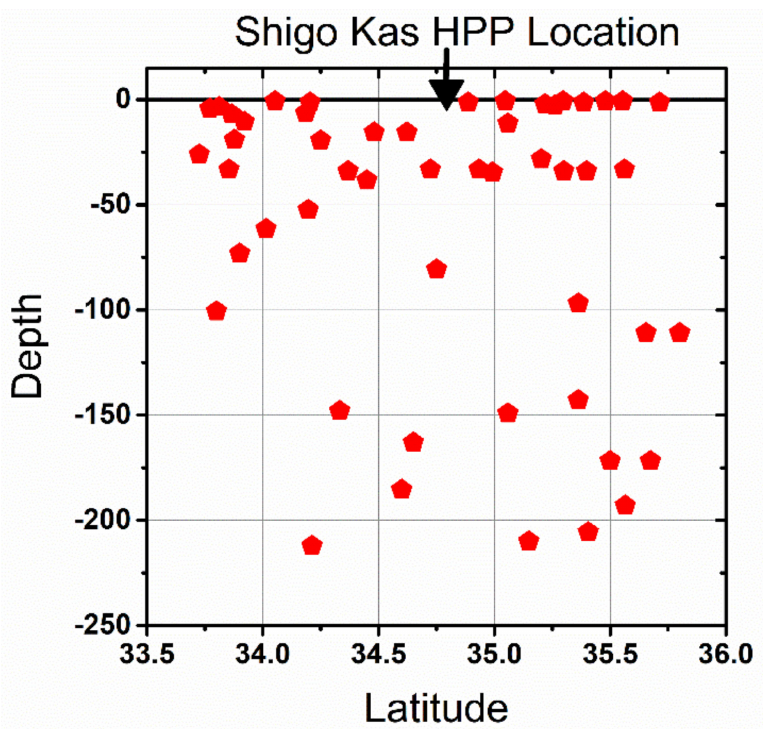
Figure 5. Focal depths in a N–S section through the Shigo Kas HPP site with a distance of 150 km on either side from the intake